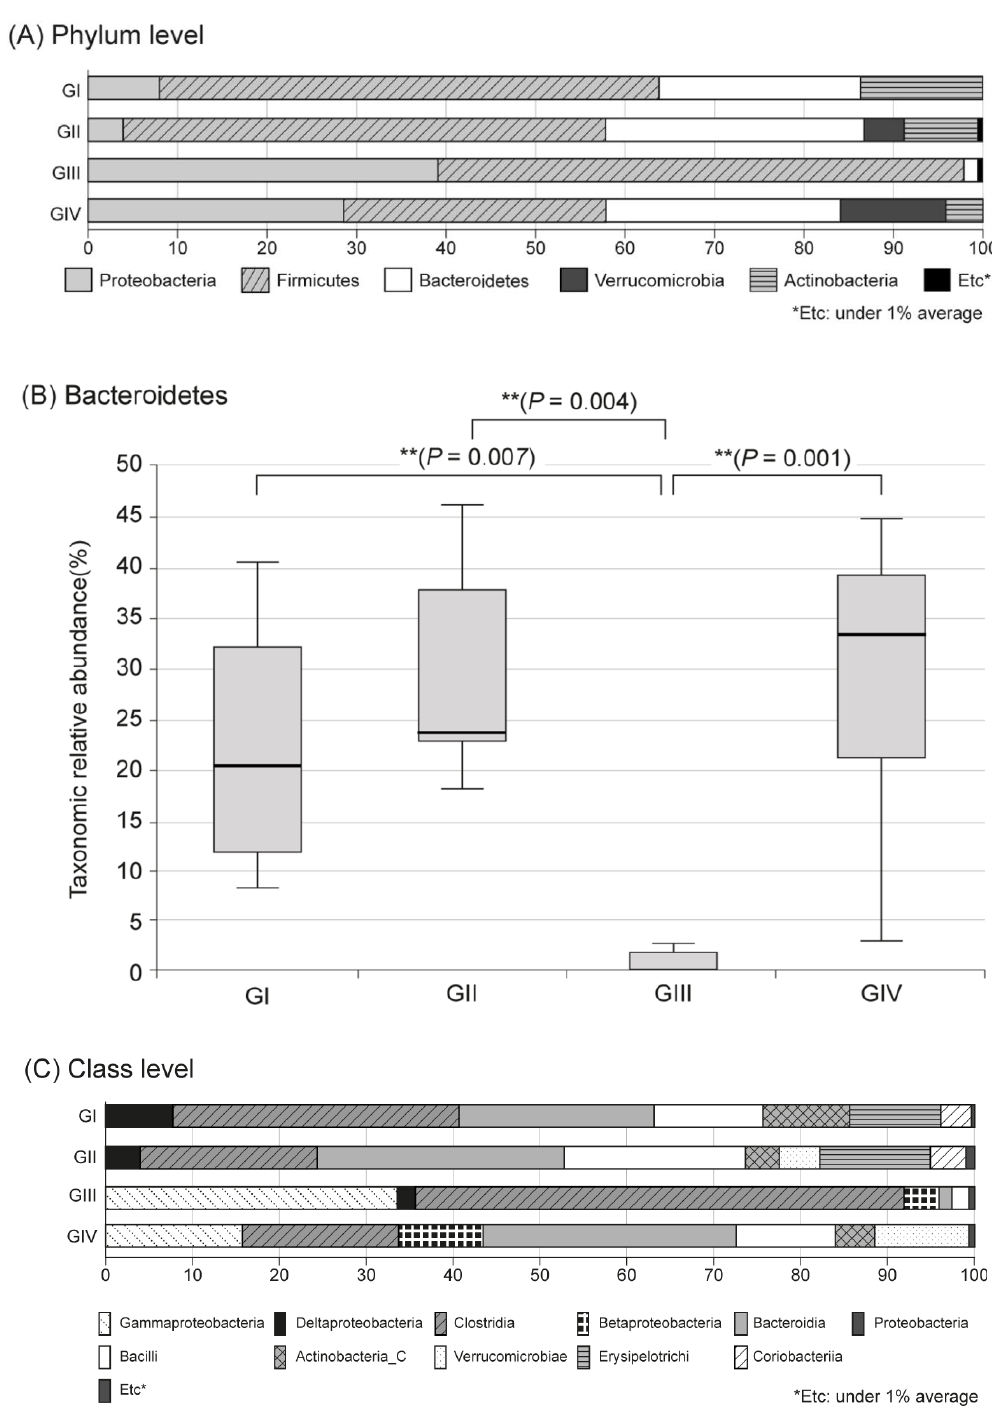
Figure 2. Microbiota composition and relative abundance distributions in four groups. ( A ) Phylum level, ( B ) Bacteroidetes, ( C ) Class level, Group I, normal group consisting of uninfected mice; group II to IV, infected mice with H. pylori ; group II, a negative control group, received distilled water as a vehicle; group III, a positive control group, treated with the standard triple therapy consisting of amoxicillin (14.25 mg / kg), clarithromycin (14.3 mg / kg), and omeprazole (138 mg / kg); group IV, treated with amoxicillin (14.25 mg / kg), gentamicin-intercalated smectite hybrid which emitted 8 mg / kg of gentamicin, and omeprazole (138 mg /